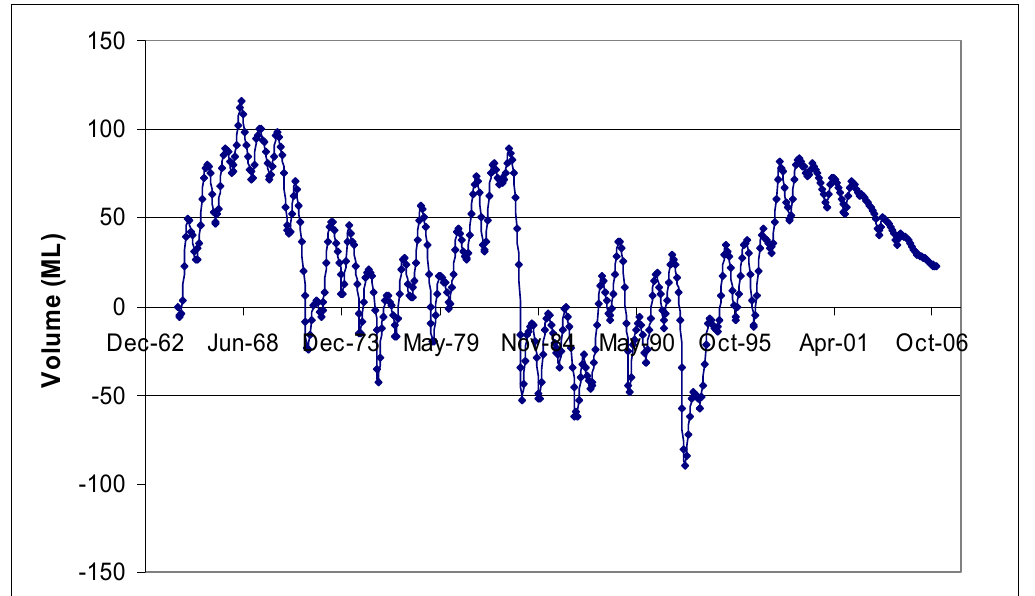
Figure 17. Volumetric groundwater component in the Lake Linlithgow water budget.